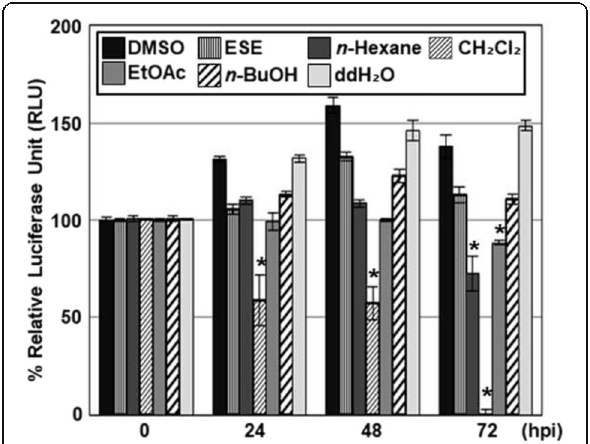
Fig. 3 Cytotoxic effects of the fractions of ESE against HFF cells. HFF cells were treated with DMSO, ESE or the n -Hexane, CH 2 Cl 2 , EtOAc, n -BuOH or ddH μ g/ml, and viability was 2 O fractions of ESE at 50 determined at 0, 24, 48 or 72 h after treatment using the CellTiter- Glo® Luminescent cell viability assay. Significant difference between samples was determined based on P values obtained from Student ’ s t test (* P <